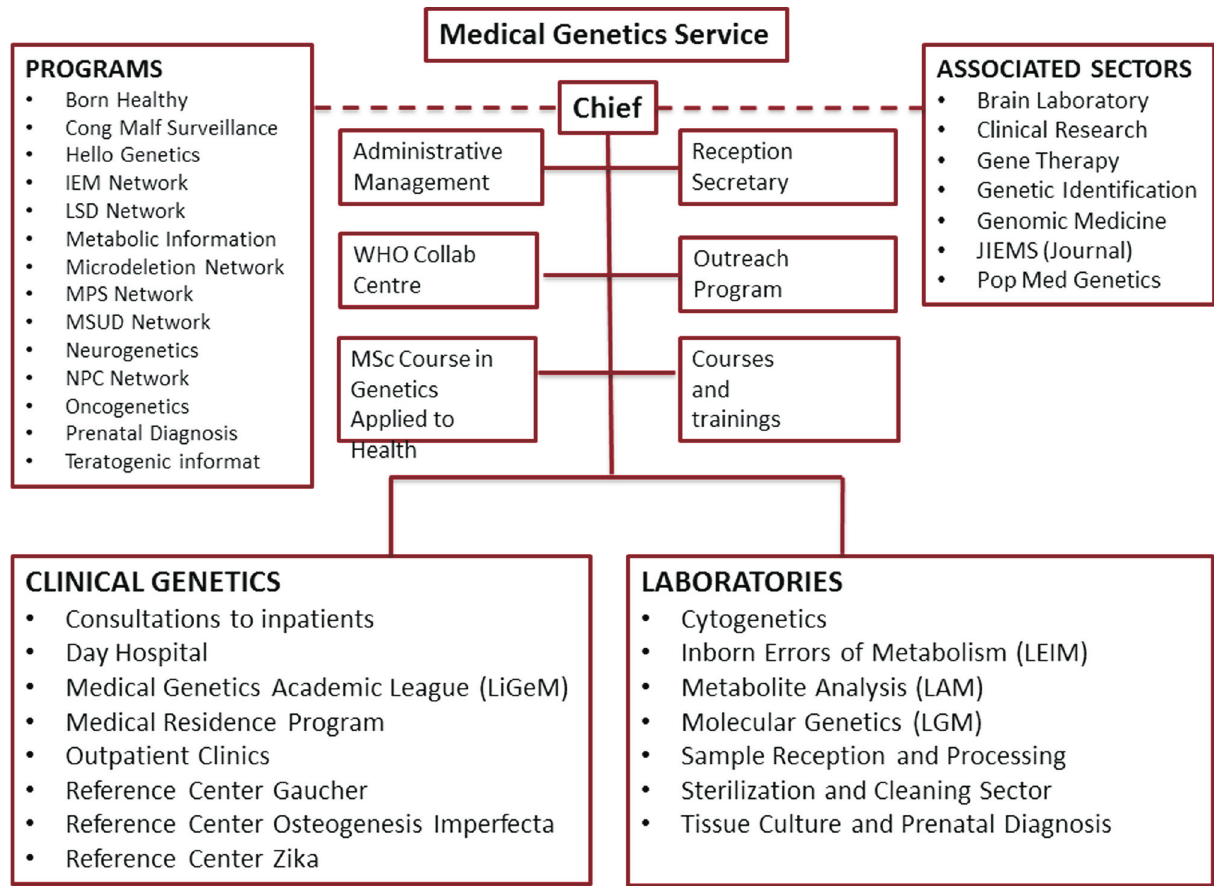
Figure 1 - Medical Genetics Service, HCPA – Organizational Chart (December